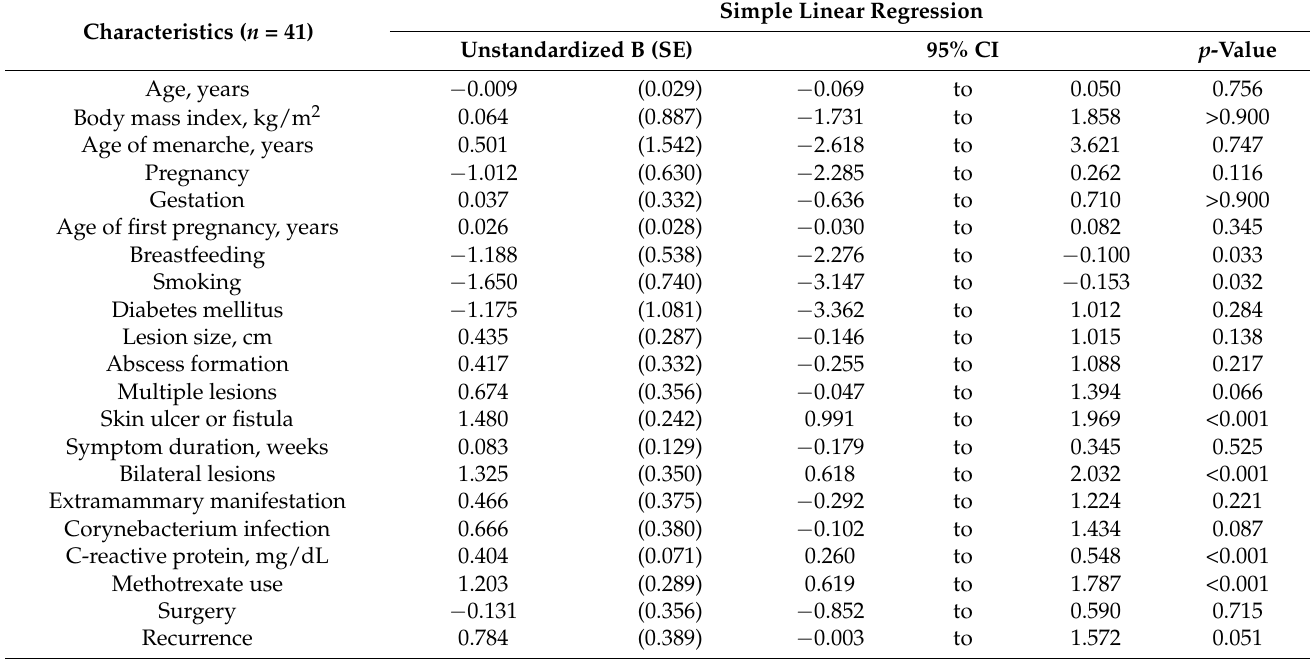
Table 3. Factors associated with time to resolution in patients with idiopathic granulomatous mastitis.